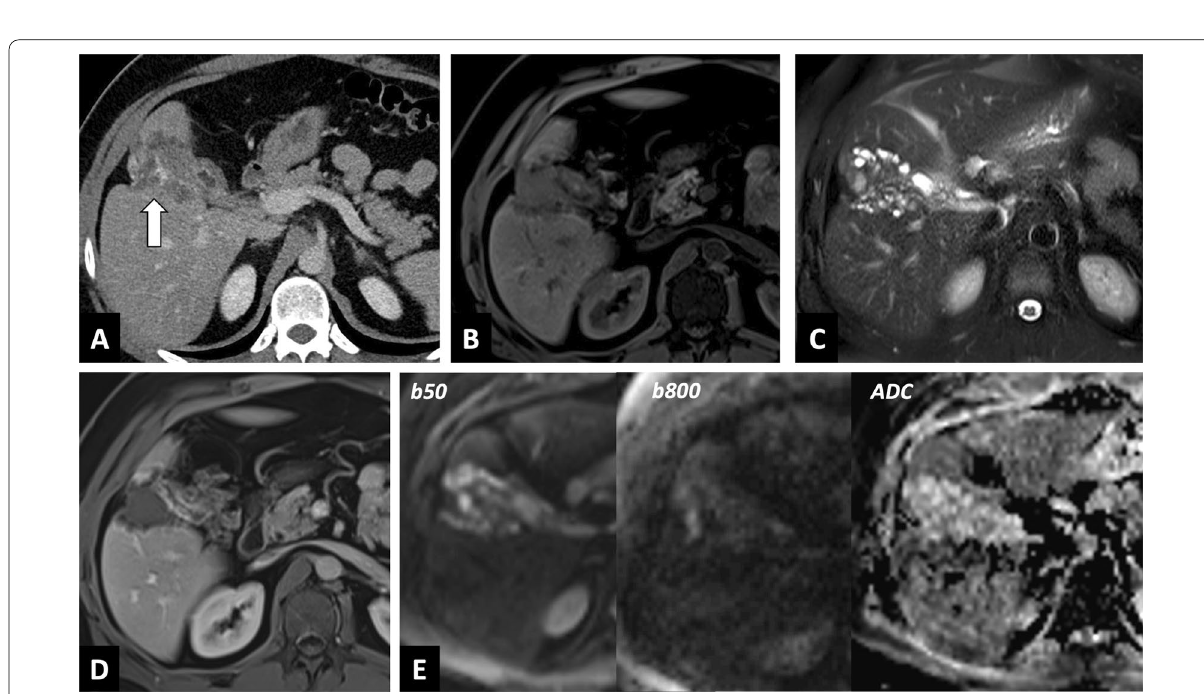
Fig. 7 Alveolar echinococcosis in a 57 year old man with an initial suspicion of gallbladder carcinoma. A CT images in the axial plane obtained during the portal phase of enhancement: infiltrative hypodense liver lesion with calcifications infiltrating the gallbladder (arrow). B Fat‑suppressed T1‑weighted sequence in the axial plane showing hypointensity of the liver lesion. C T2‑weighted fat‑suppressed MR image in the axial plane showing typical microcysts within hypointense T2 lesions (arrowheads). D Diffusion‑weighted imaging showing suppressed hyperintensity on b800 corresponding to high ADC